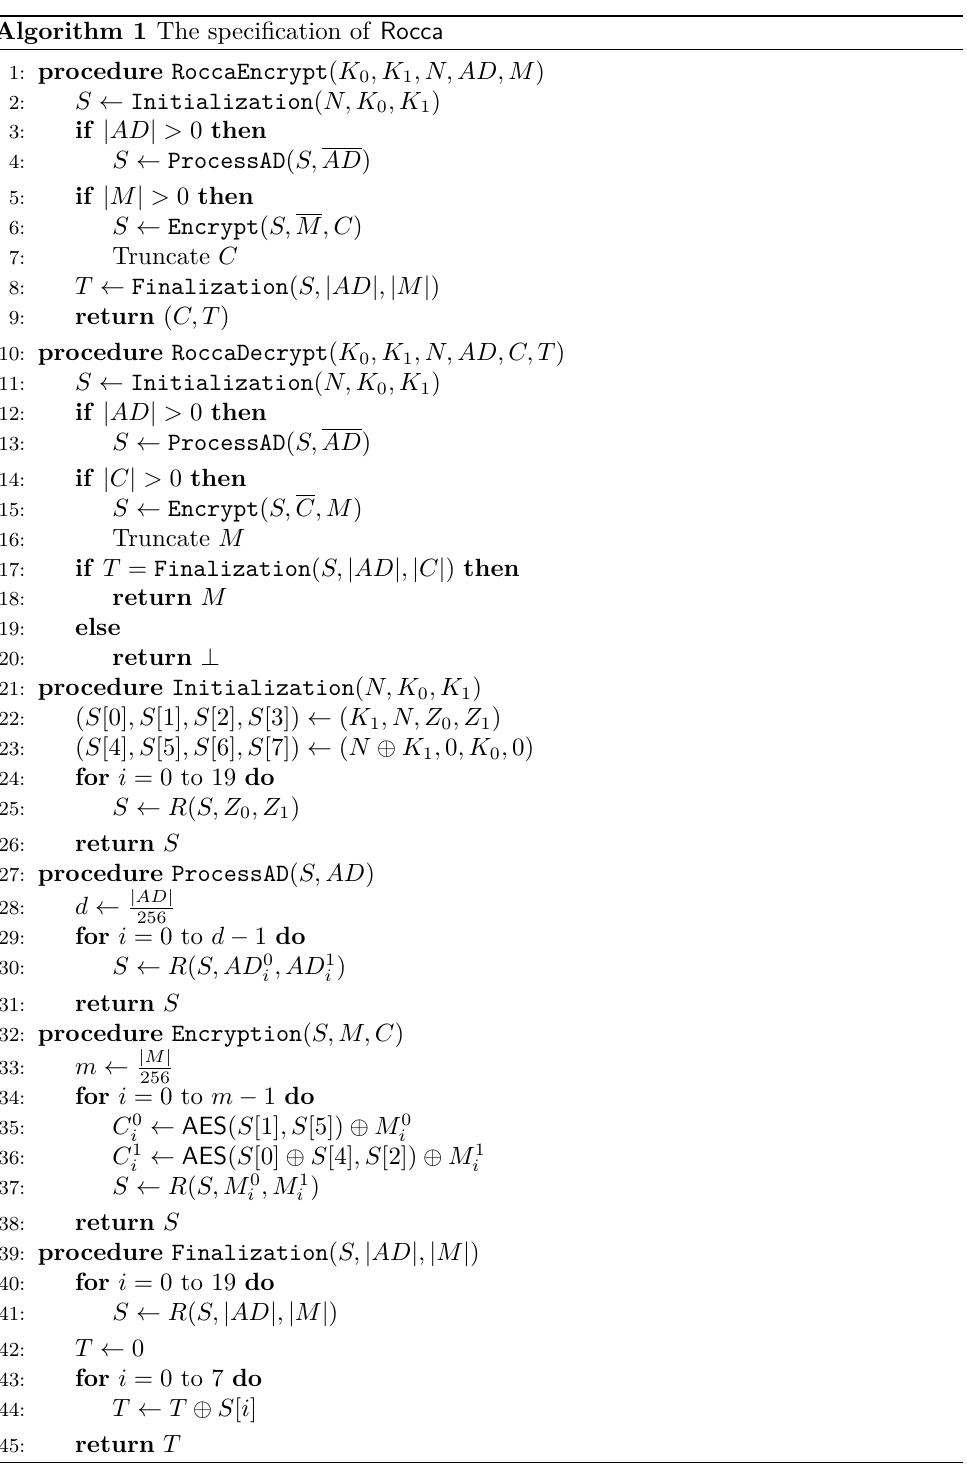
Algorithm 1 The specification of